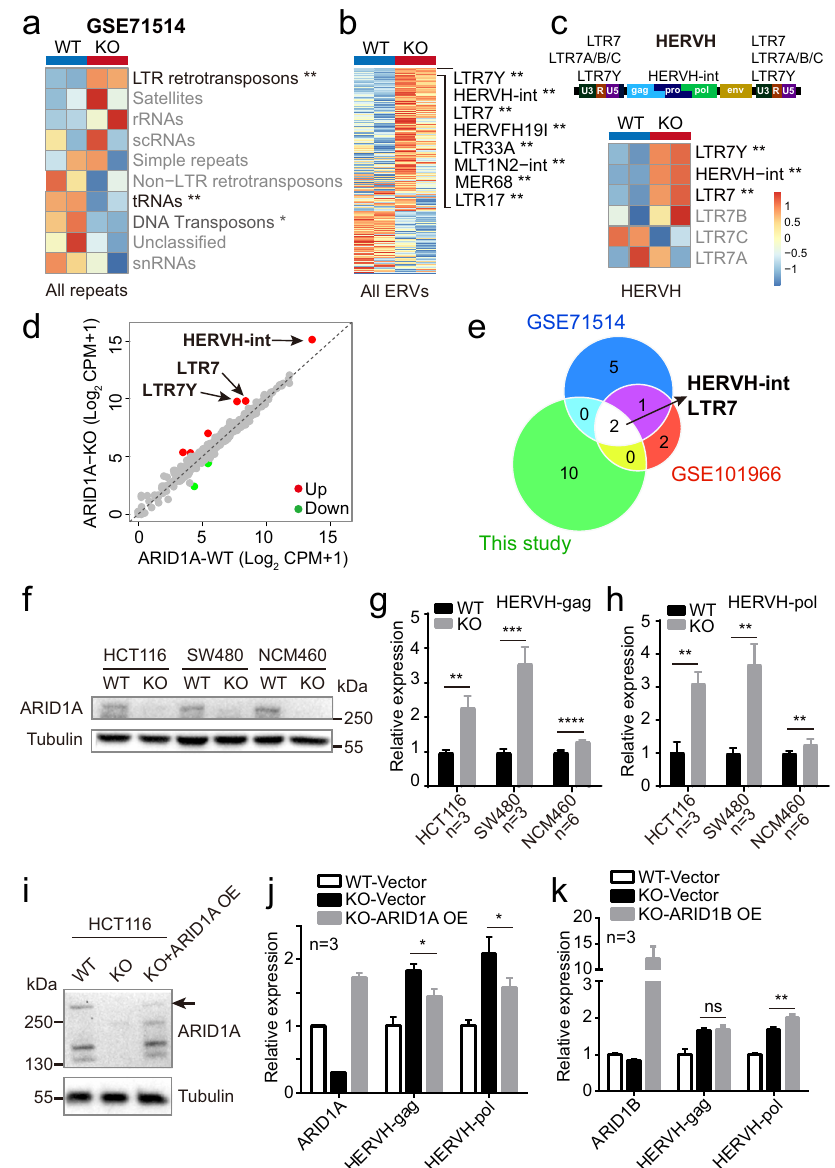
Fig. 2 ARID1A loss leads to upregulation of HERVH. a – c Heatmaps of the expression of different repetitive sequences in wild-type (WT) and ARID1A knockout (KO) HCT116 cells. The differential expression is tested based on a model using the negative binomial distribution by DESeq2 (version v1.22.2, with two-tailed likelihood ratio test). The adjusted p values are labeled as * p < 0.05, ** p < 0.01. The schematic of a typical full-length HERVH element is shown in c . d Scatter plot of the expression of all 580 ERVs in WT and KO HCT116 cells. The up (red) and down (green) regulated ERVs are determined by DESeq2 (version v1.22.2, with two-tailed likelihood ratio test) using cut-off values of adjusted p value <0.05 and |Log 2 FC | > 1. e Venn diagram showing that HERVH is repetitively upregulated in three independent sequencing experiments with HCT116 ARID1A WT and KO cells. f Western blots of different ARID1A WT and KO cell lines. Results are representative of three independent experiments. g , h qPCR analyses of HERVH expression in ARID1A WT and KO cell lines using two different primer sets. Data are presented as mean values ± SD from at least three independent experiments, two-tailed unpaired t test, ** p < 0.01, *** p < 0.001, **** p < 0.0001. i Western blots showing ARID1A protein levels in WT, KO, and ARID1A rescued KO HCT116 cells. Results are representative of three independent experiments. Arrow indicates the full-length ARID1A band. j qPCR analysis of ARID1A and HERVH expression in the indicated cells. Data are presented as mean values ± SD from three independent experiments, two-tailed unpaired t test, * p < 0.05. k qPCR analysis of ARID1B and HERVH expression. Data are presented as mean values ± SD from three independent experiments, two-tailed unpaired t test, ns: not signi fi cant, ** p < 0.01. Source data including exact p -values are provided as a Source data fi le. Expression of HERVH is required for the survival of colorectal (Fig. 4a). Of note, given that the HERVH transcripts were pro- cancer cells . Knockdown the expression of HERVH in ESCs duced from multiple evolutionarily related genomic loci, different triggers differentiation 15 . To investigate the function of HERVH shRNAs demonstrated certain selectivity toward different subsets transcription in CRCs, we knocked down its expression in cell of the HERVH elements (Supplementary Data 7). lines and patient-derived organoids using three different shRNAs We fi rst evaluated the effects of HERVH knockdown in WT targeting the HERVH-int region and assessed the consequences and ARID1A KO HCT116 cells. All the three shRNAs treatments NATURE COMMUNICATIONS| (2022) 13:3501